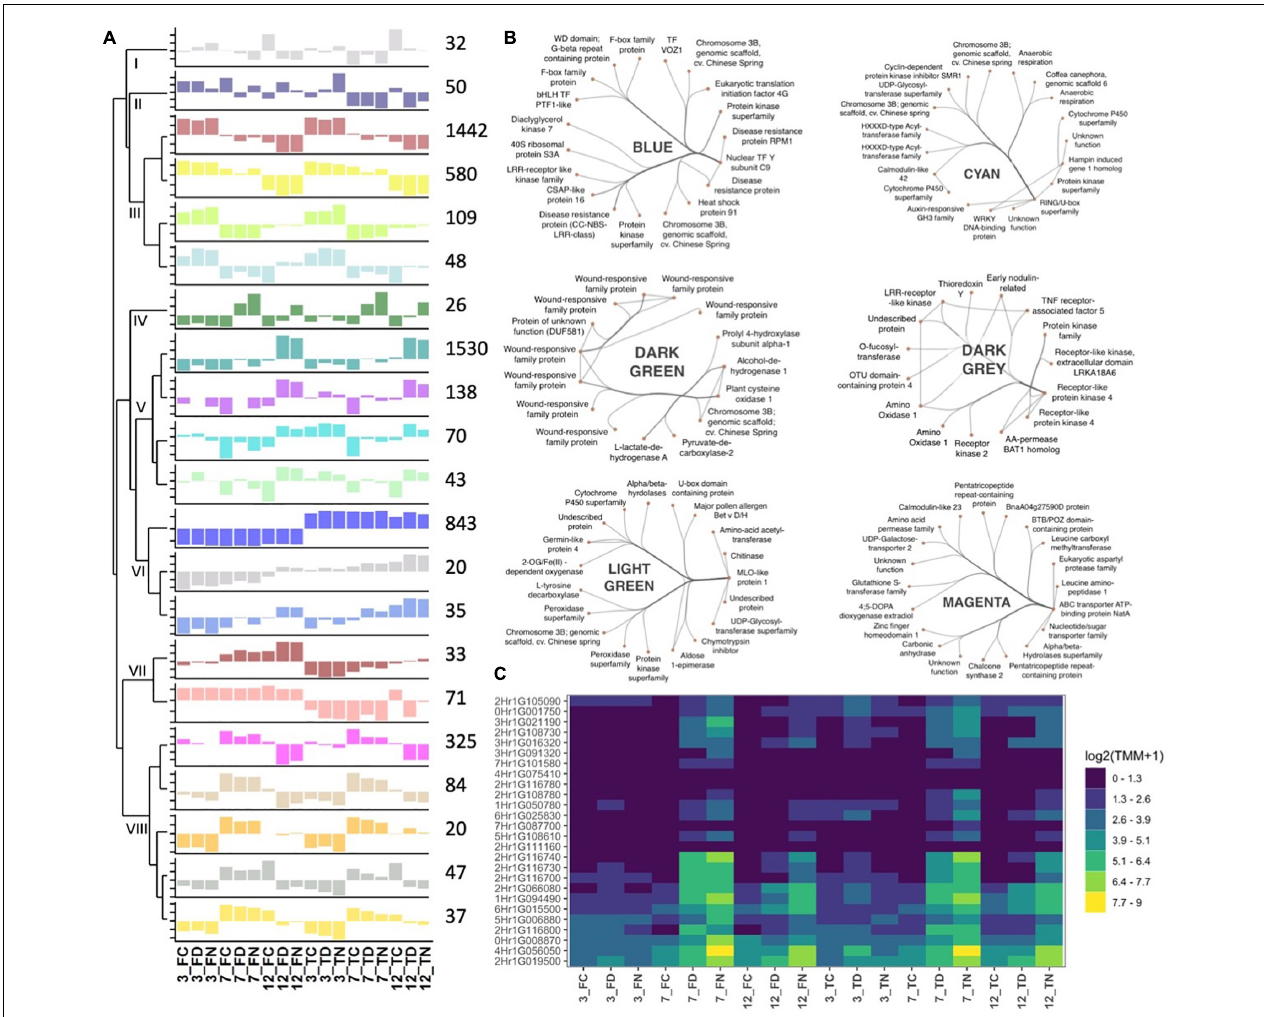
FIGURE 5 | Eigenvalue barplot for co-expression analysis. (A) Each plot depicts the average eigengene values across the biological replicates for all interactions at each time point. Dendrogram sorts modules according to their hierarchical clustering. Numbers close to the module dependent bar plots show the number of gene included in each module. The names of the modules are as following: (I) gray; (II) midnightblue; (III) brown, yellow, greenyellow, and lightcyan, (IV) darkgreen; (V) darkturquoise, purple, cyan, and lightgreen; (VI) blue, darkgray, and royalblue; (VII) darkred and salmon; (VIII) magenta, tan, orange, gray60, and lightyellow. (B) Gene networks for selected modules for 20 highest hub gene connections. (C) Expression levels of genes (TMM, trimmed mean of M) in the darkgreen module. Gene IDs are shortened ( HORVU removed). F, fairytale; T, tipple; D, Ramularia isolate DK05; N, Ramularia isolate